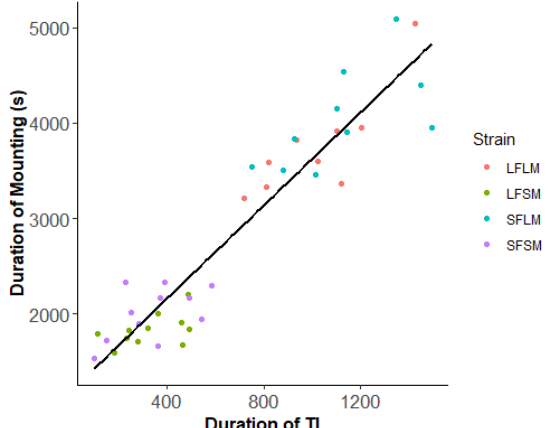
Figure 8. The relationship between the duration of TI and mounting in male SPWs. The four colors indicate different treatments: red—LF and LM; green—LF and SM; blue—SF and LM; purple—SF and SM (y = 1190 + 2.44T ti , R 2 = 0.89).